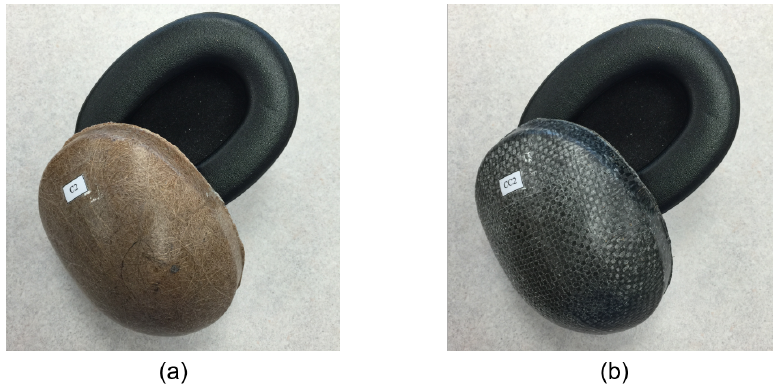
Figure 1. Closed-up view of the composite ear cups assembled with the inner foam lining and cushion: ( a ) coir fibre-reinforced polypropylene (Coir-PP); and ( b ) coir/carbon fibre-reinforced polypropylene (Coir/C-PP).